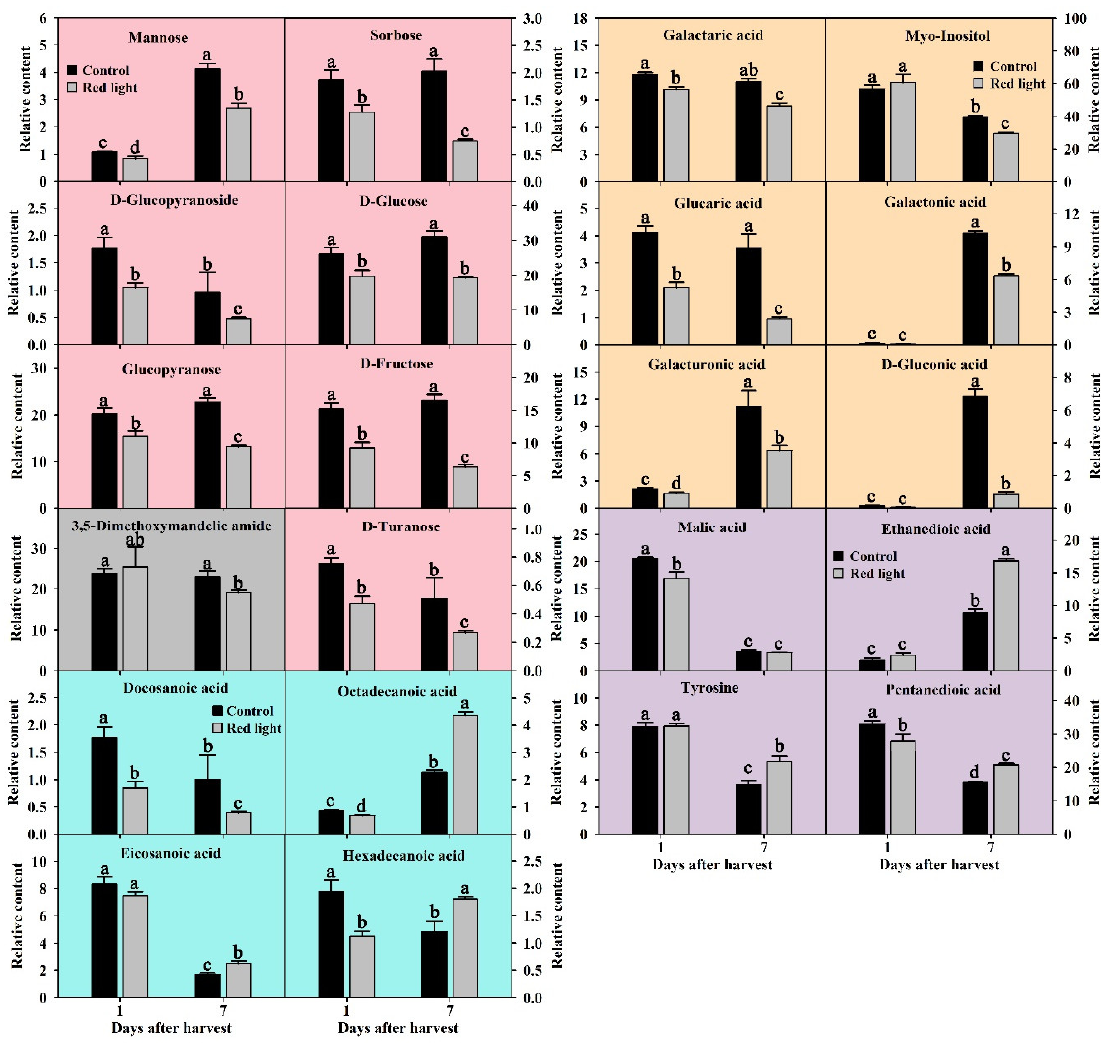
Figure 4. The changes of key primary metabolites after red light irradiation. Soluble sugars were shown in red-pink bar charts. Cell wall degraded products were shown in yellow bar charts. Fatty acids were shown in blue bar charts. Organic acids and amino acid were shown in purple bar charts. Others were shown in gray bar charts. The significant differences were labelled with letters a, b, c, and d, according to Duncan’s test ( p < 0.05).